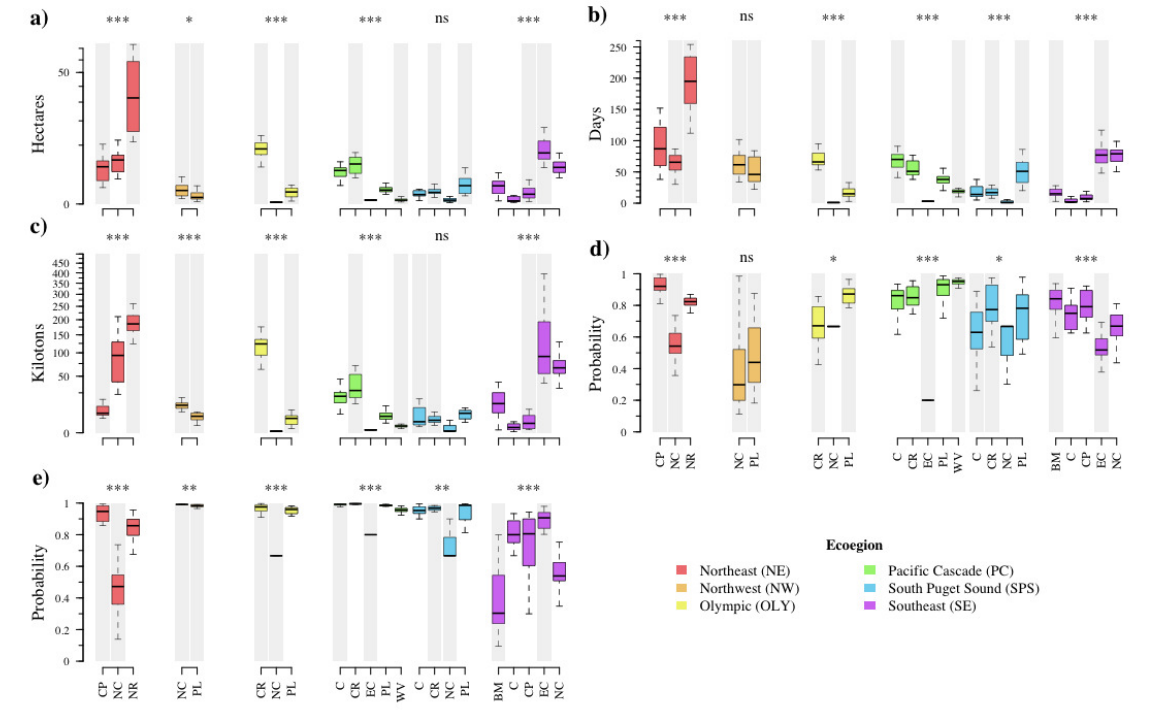
Figure 4. Boxplot comparison of five annual prescribed fire parameters across ecoregions different ecoregions contained within each DNR administrative region (Ecoregions: Blue Mountains (BM), Cascades (C), Coast Range (CR), Columbia Plateau (CP), Eastern Cascades Slopes and Foothills (EC), North Cascades (NC), Northern Rockies (NR), Puget Lowland (PL), and Willamette Valley (WV)). Each panel describes the conditional distributions of a prescribed fire parameter: burned area ( a ), burn days ( b ), burned biomass ( c ), approval probability ( d ), and pile probability ( e ). p -values greater than 0.03 are interpreted as not significant (ns), p -values less than 0.03 are interpreted as significant (*), p -values less than 0.0075 are interpreted as strongly significant (**), and p -values less than 0.0005 are interpreted as very strongly significant (***). See Section 2.2.1 for details. The two ecoregions within each administrative with the most important (lowest p -value) difference are highlighted in